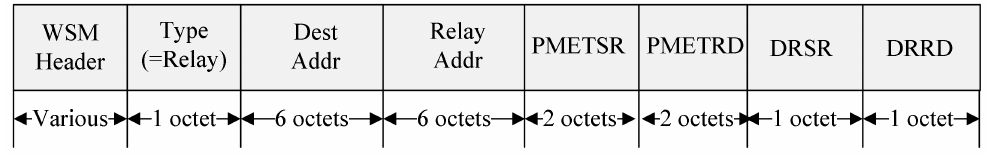
Figure 4. The format of the proposed Coop Relay